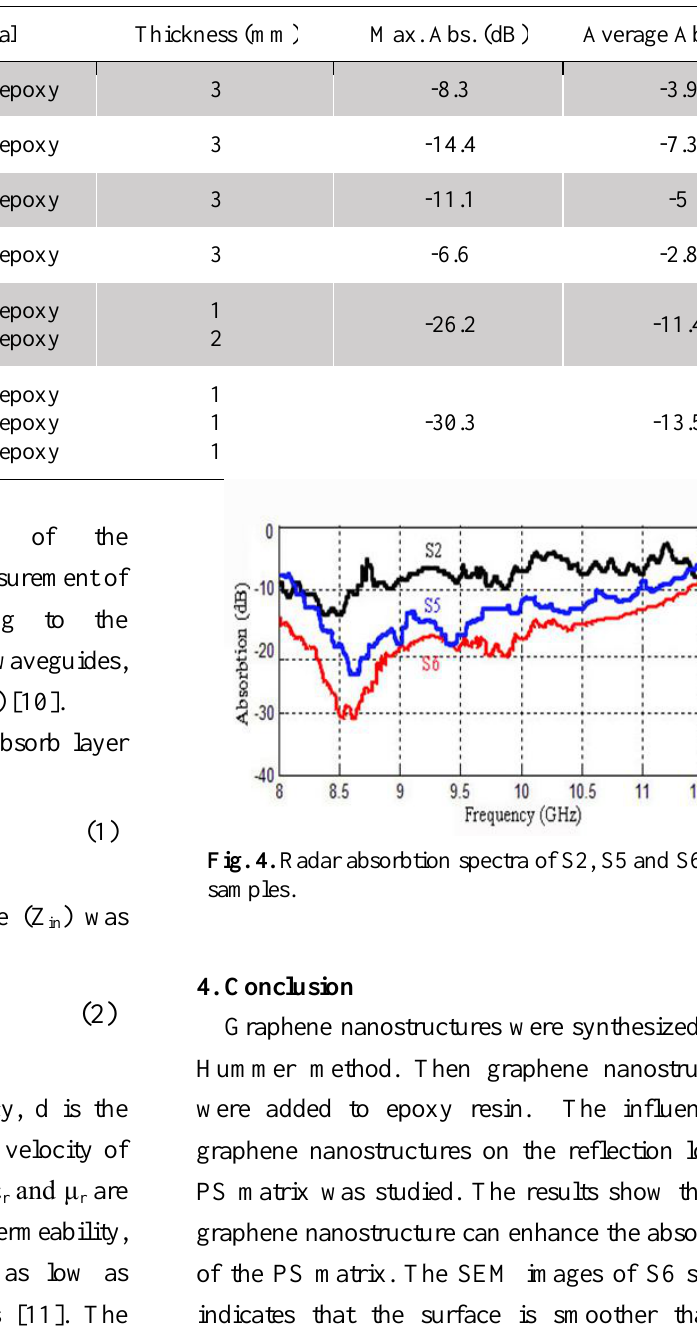
Table 1. Configurations and performances of single layer and multi layer absorbing samples.